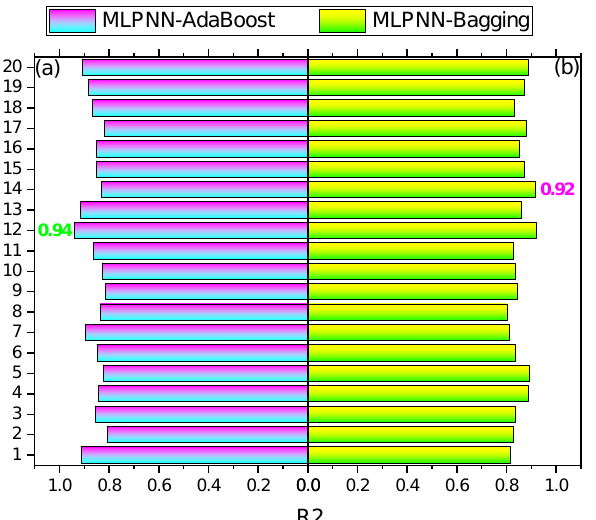
Figure 19. Flexural strength sub-models results: ( a ) MLPNN-AdaBoost; ( b ) MLPNN-Bagging.